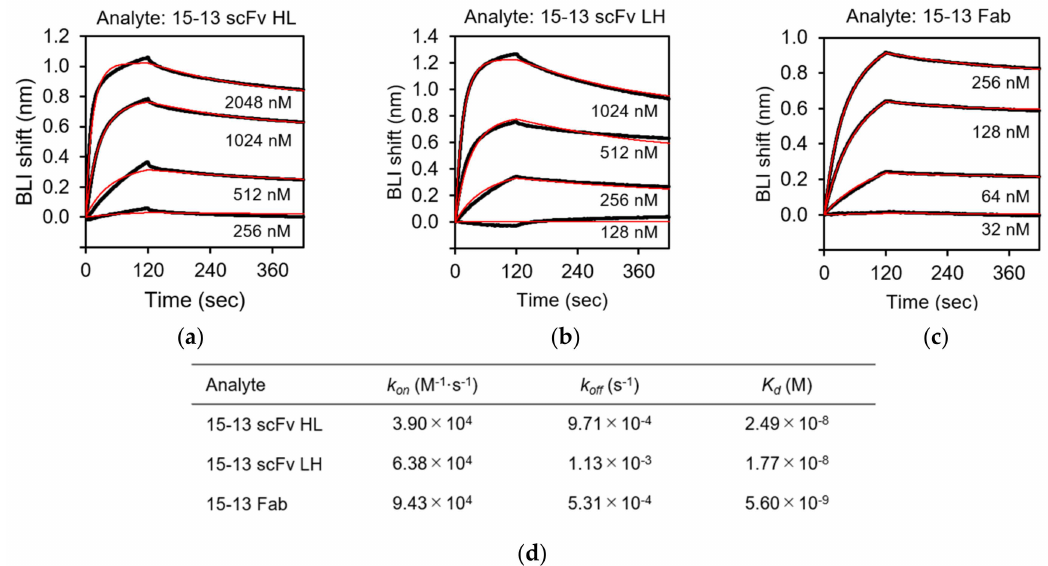
Figure 5. Binding analysis of rRABVG by 15–13 fragments. Binding analysis of anti-RABVG antibodies with rRABVG immobilized on the Ni-NTA biosensor were performed. Representative sensorgrams for the rRABVG binding responses of: ( a ) 15–13 scFv HL; ( b ) 15–13 scFv LH; and ( c ) 15–13 Fab are shown. The sensorgrams were globally fitted with a 1:1 binding model (red lines). ( d ) Affinity constants ( K d ), association ( k on ), and dissociation ( k off ) rate constants were derived by nonlinear curve fitting using BLItz Pro version 1.2.1.3.